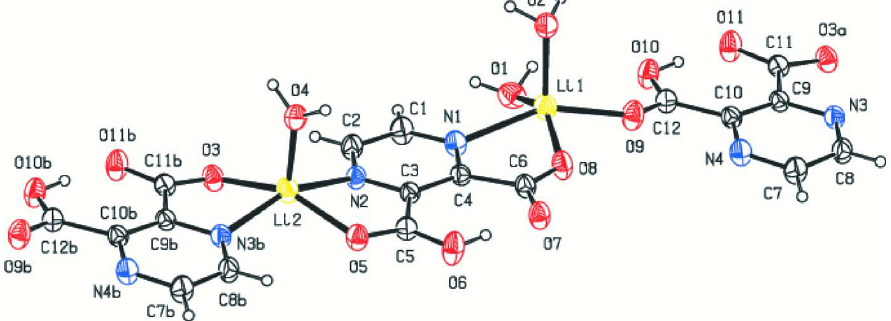
Showing the atom-labelling scheme of (I). Displacement ellipsoids are drawn at the 30% probability level. [Symmetry codes: ( a ) -1 + x , y , -1 + z ; ( b ) 1 + x , y ,1 + z